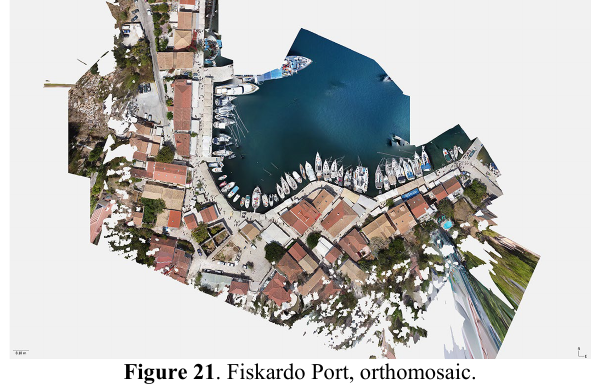
Figure 21 . Fiskardo Port, orthomosaic.